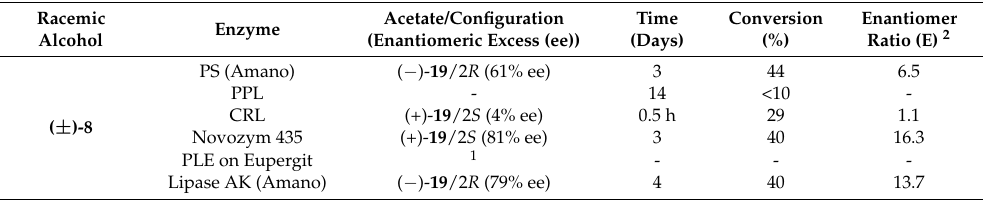
Figure 6. Lipase-mediated acetylation of racemic (2,6,6-trimethyltetrahydro-2 H -pyran-2-yl)methanol 8 . Reagents and conditions: t -BuOMe/vinyl acetate 5:1, rt, concentration of ( ± )- 8 : 1 M. Results are collected in Table 1. Table 1. Results of the enzyme-mediated acetylation of racemic alcohol 8